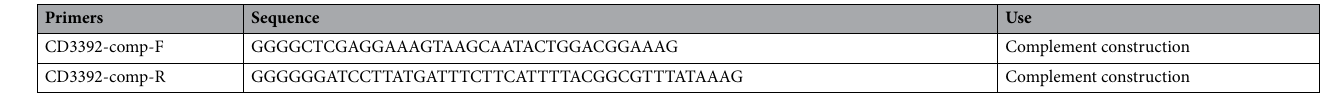
Table 1. List of strains and